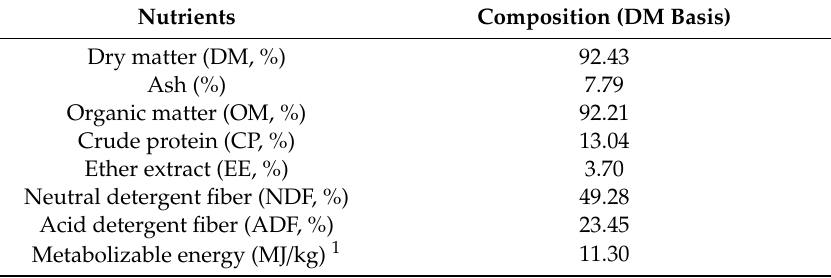
Table 1. Nutrient (proximate) composition of the pelleted diet fed to male Najdi lambs during the study.